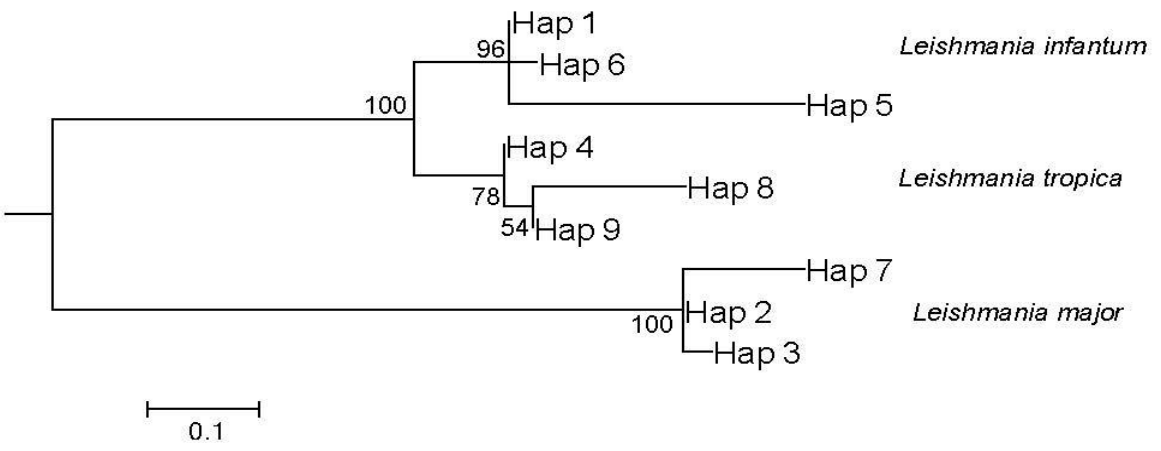
Figure 5. Maximum likelihood phylogenetic tree for 9 haplotypes of all Tunisian Leishmania para- sites based on ITS1-rDNA gene sequences. Sequences fitting for each haplotype were defined in Supplementary Table S2. The numbers above the branches are bootstrap percentages of 1000 repli- cations.